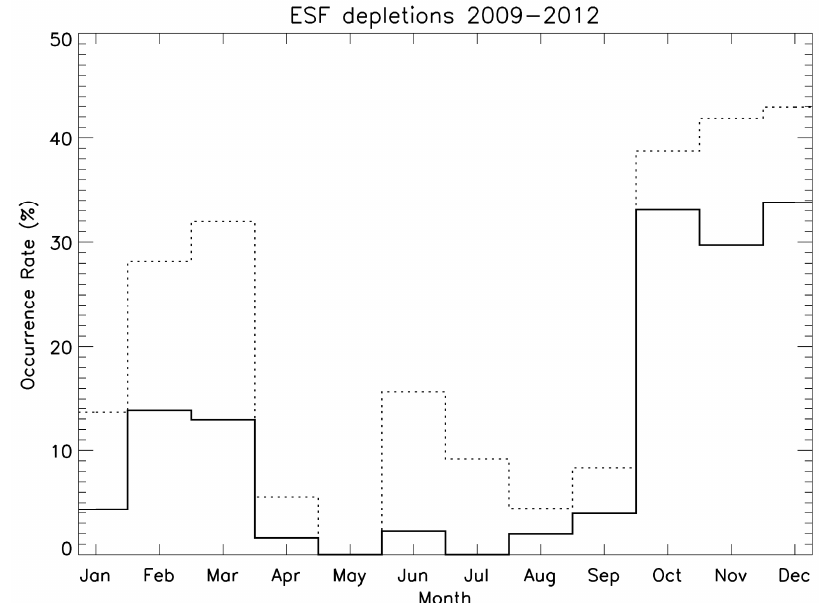
Figure 4. Occurrence rate of ESF depletions observed at Mercedes (dashed lines) and Arecibo (solid lines). Similar seasonal dependence is observed at both sites, with peak occurrence during the December